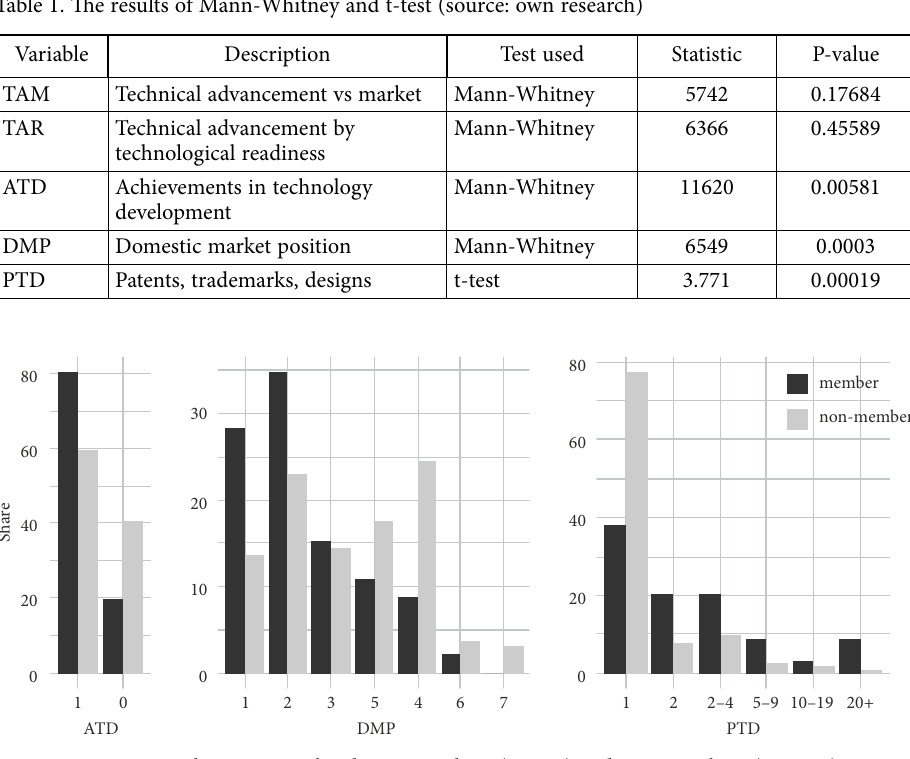
Figure 1. Survey results-responses by cluster members (n = 46) and non-members (n = 418), in % (source: